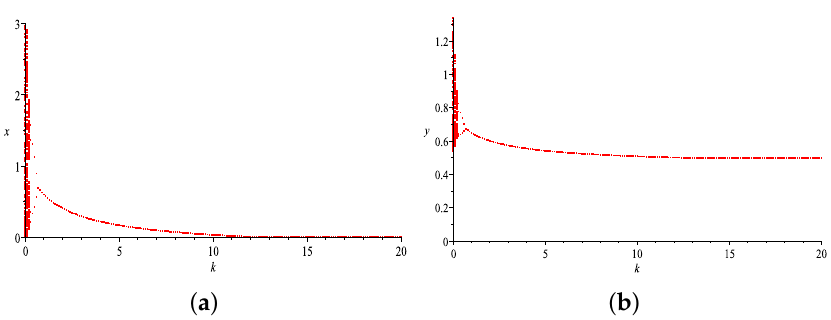
Figure 6. ( a ) The globally stability of the prey species population. ( b ) The globally stability of the predator species population, where r 0 = 4 and other parameters are given in (58).